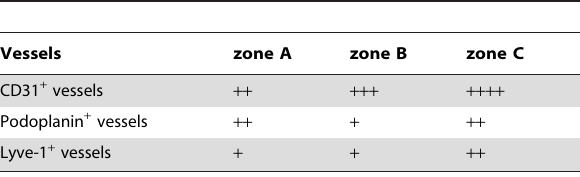
Table 1. Vessel density in zone A, B and C of the onchocerca nodule.